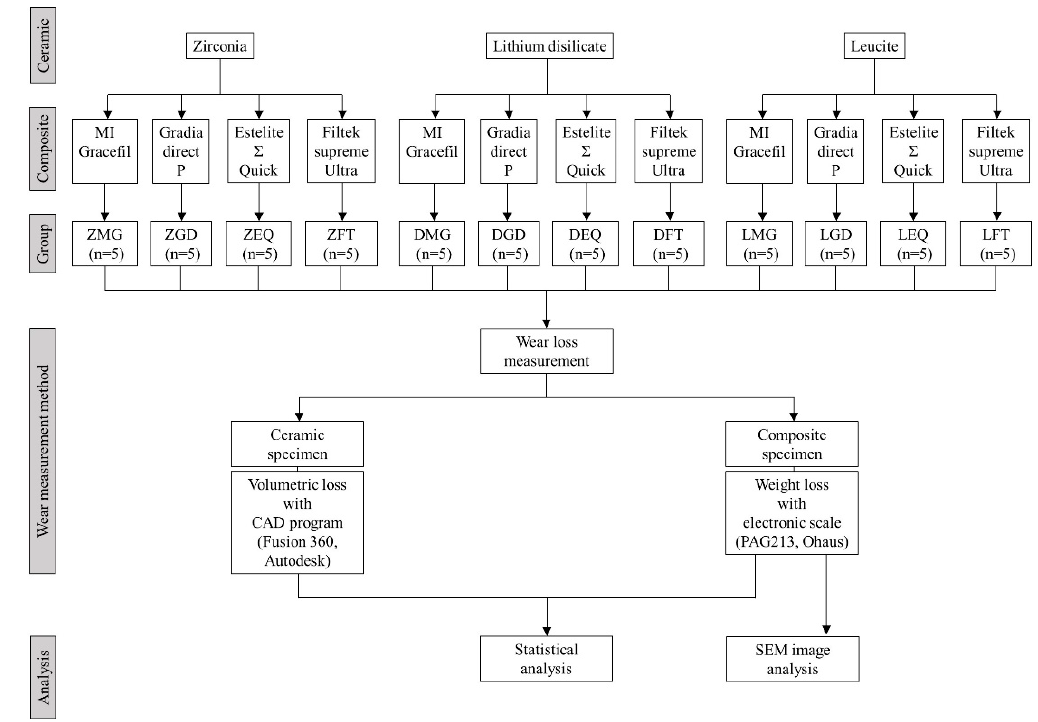
Figure 1. Flow-chart of the study.